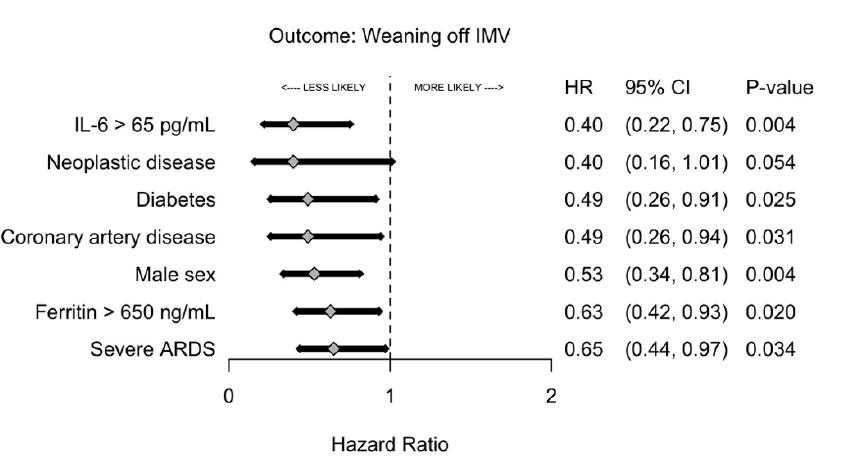
Figure 2. Likelihood of weaning off invasive mechanical ventilation by risk factors. The forest plot analysis is a multivariable logistic regression with cluster-robust standard errors that was selected using a forward and backward stepwise selection procedure based on overall model likelihood.